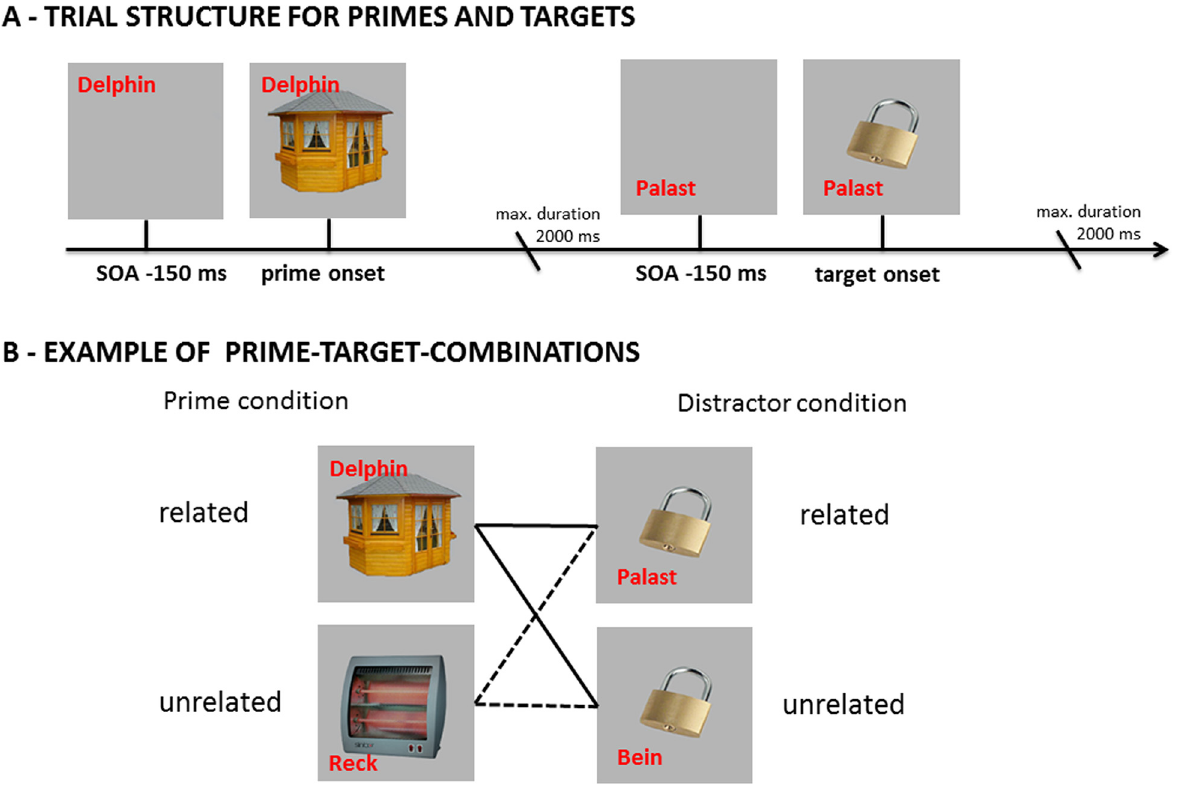
Fig 2. Trial structure for prime and target stimuli and combinations of the prime and distractor conditions. (A) The target picture set consisted of objects with homonymous names. For example: a picture of a lock called “ Schloss ” (also denoting a castle). Prior to target presentation, a prime stimulus was presented that was categorical related to the non-depicted meaning of the homonymous name. Here, the picture of bower called “ Laube ” is categorically related to the non-depicted meaning (castle) of the following target. -150 ms before picture presentation a distractor word was presented for the prime and target stimuli. The distractor word was categorically related or unrelated to the non-depicted meanings of target stimuli (e.g. “ Palast ” (palace) related to the non-depicted meaning of a castle). In the prime condition distractor words were always unrelated. (A) The prime stimulus presented one trial before the targets could be categorically related or unrelated to the non-depicted meaning of the target ‘ s homophone name and was always unrelated to the depicted meaning. Each prime condition (related: “ Laube ” (bower), unrelated: “ Heizlüfter ” (heater)) was crossed with the two distractor conditions of the target stimuli (related: “ Palast ” (palace); unrelated: “ Bein ” (leg)).